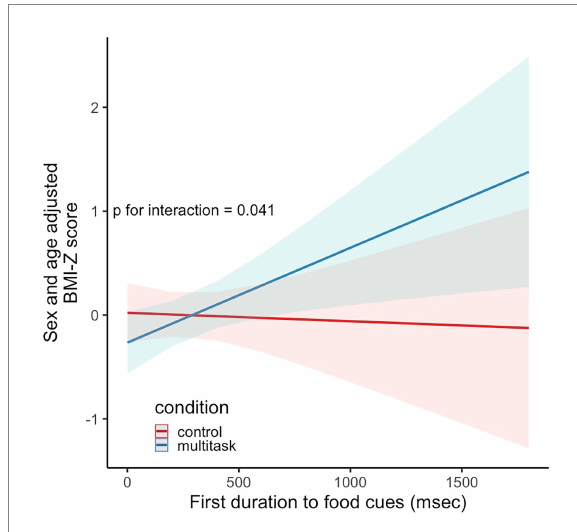
FIGURE 1 Predicted sex and age adjusted BMI-Z scores for the first fixation to food cues by condition (multitask versus control) interaction. Shaded areas represent the standard